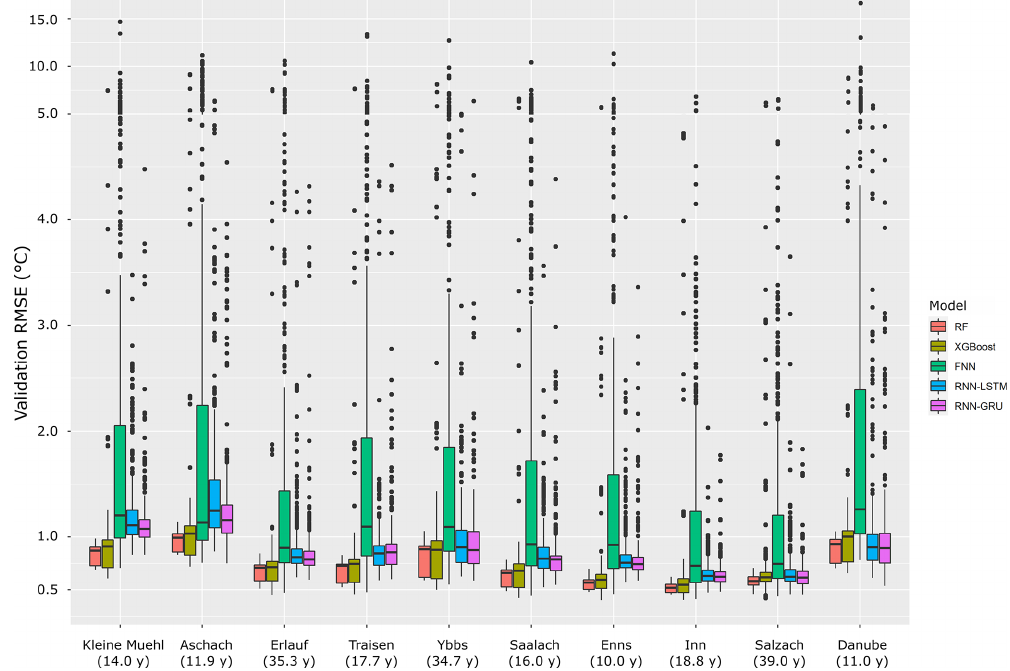
Figure 6. Boxplots showing the validation RMSE distribution for different hyperparameter sets for all model types, catchments and exper- iments. The catchments are ordered by catchment size from smallest (left) to largest (right), with additional information of the available time-series length in parentheses below.